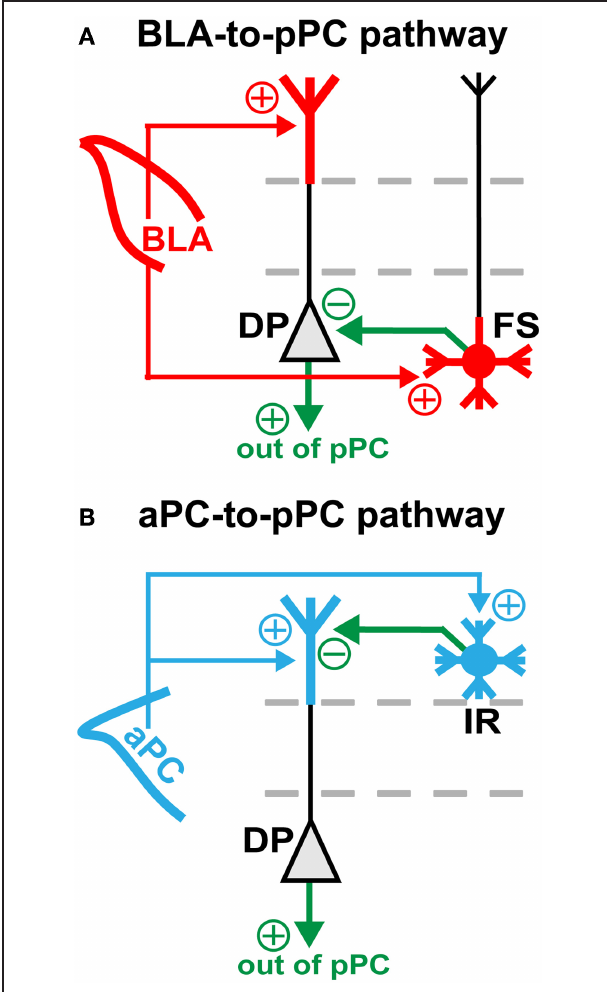
FIGURE 4 | BLA- and aPC-dependent feed-forward inhibition in the pPC. Diagrams showing the proposed (A) BLA- and (B) aPC-to-pPC functional connective schemes. Red and blue arrows represent BLA and aPC axonal projections, respectively. Green arrows represent axons emanating from local pPC excitatory (triangle) or inhibitory (circle) neurons. Plus ( + ) and minus ( − ) signs indicate whether axons are excitatory or inhibitory. Note that the BLA drives feed-forward somatic inhibition, while the aPC drives feed-forward dendritic inhibition of pPC pyramidal cells—DPs and SPs